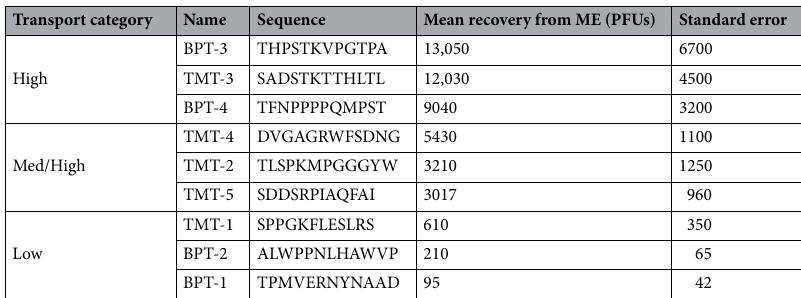
Table 1. Sequences and ME recovery of trans-TM 12-mer peptide phage identified by two screening methods (data from Kurabi et al. 19 ). Each purified phage was applied to the TM of previously infected rats for one hour (n = 6), and the ME contents then tittered and the number of phage particles recovered were averaged (mean of n = 6). Phage recovery was grouped into transport categories, which were then used to generate Fig. 1.